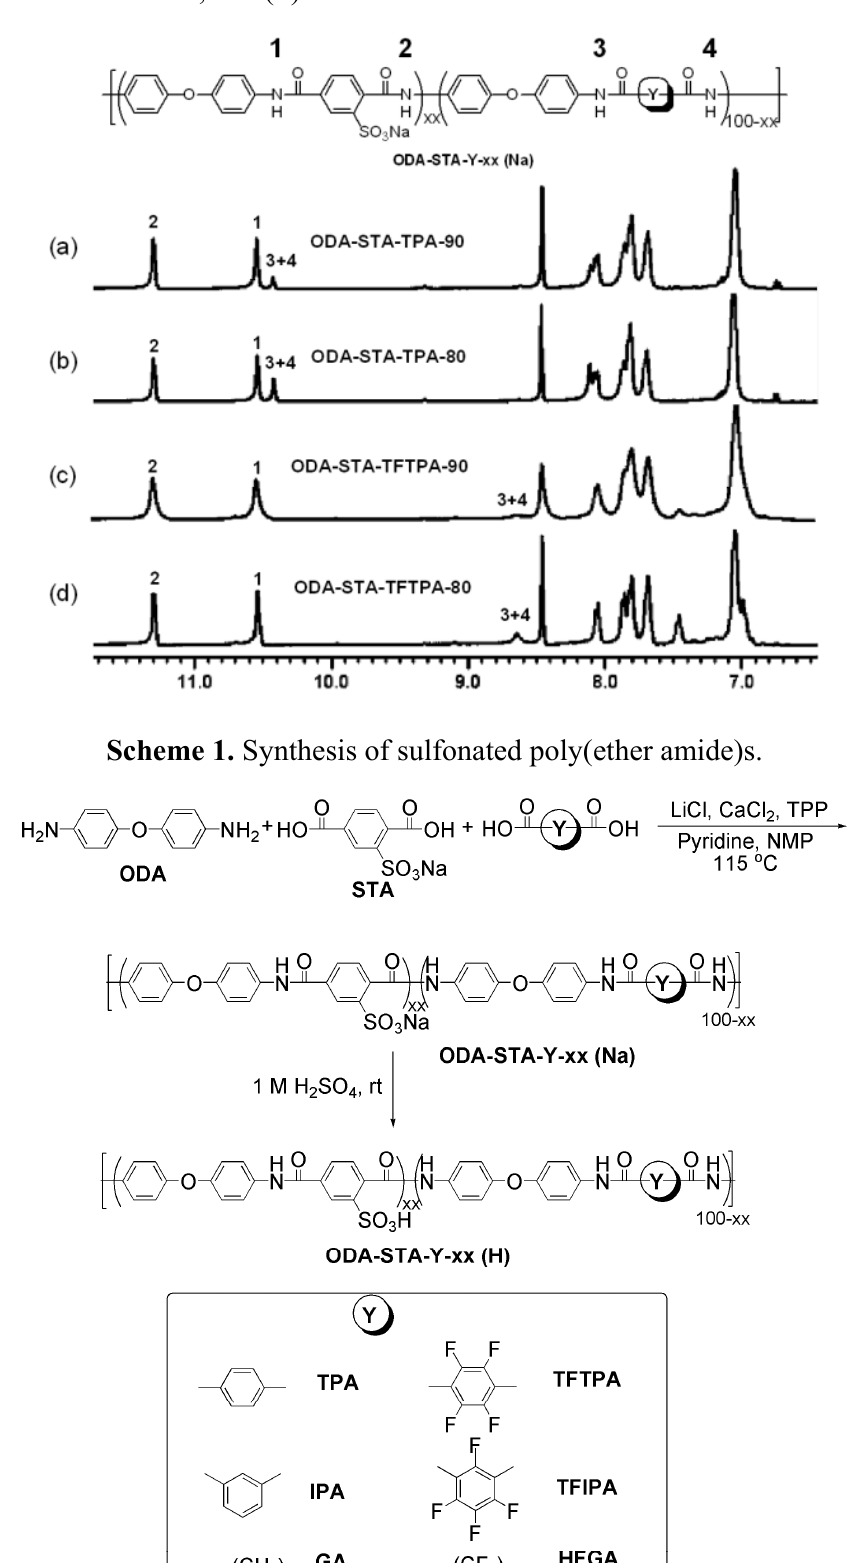
Figure 1. 1 H NMR (DMSO-d ) spectra of ( a ) ODA-STA-TPA-90, ( b ) ODA-STA-TPA-80, 6 ( c ) ODA-STA-TFTPA-90, and ( d ) ODA-STA-TFTPA-90.